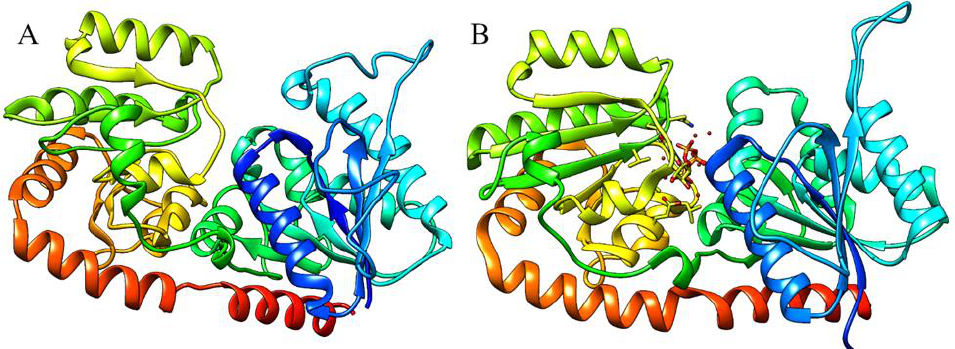
Figure 2. The predicted model of NmW-GT domain. ( A ) I-TASSER-generated model; ( B ) BshA template (PDB: 6D9T). The models are colored from the N-terminus (blue) to the C-terminus (red). The overall topology is considered accurate based on the I-TASSER quality scores [30,32,70].